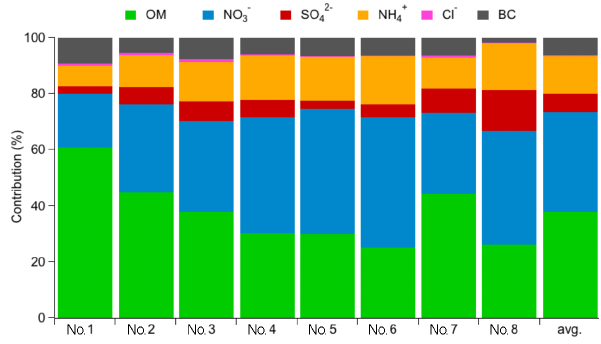
Figure 12. PM 1 chemical composition of the eight pollution